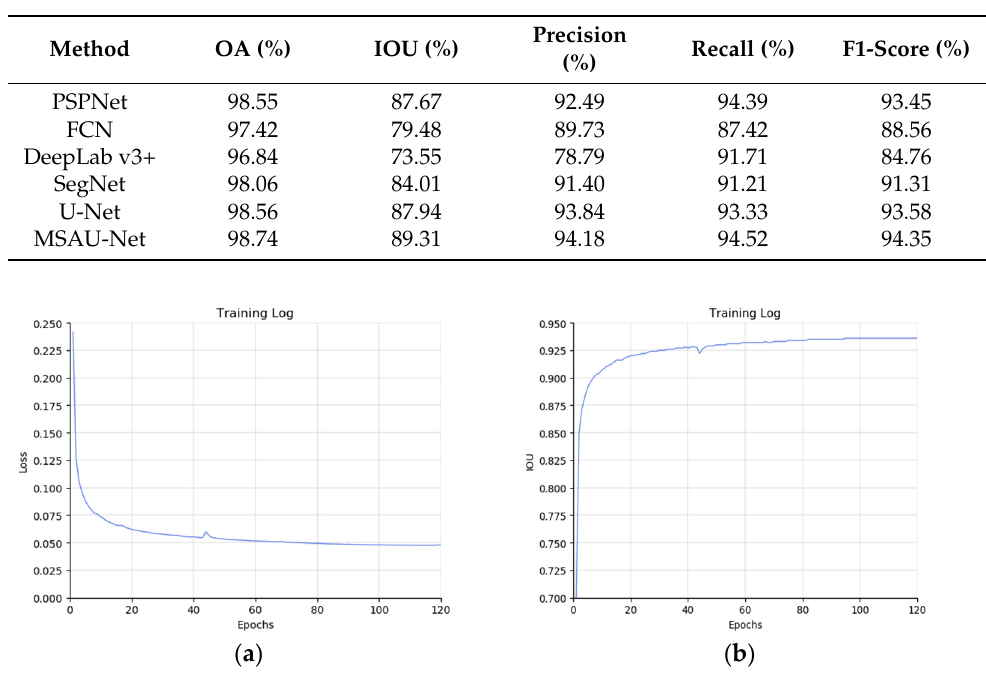
Table 1. Experimental results of the WHU building dataset.